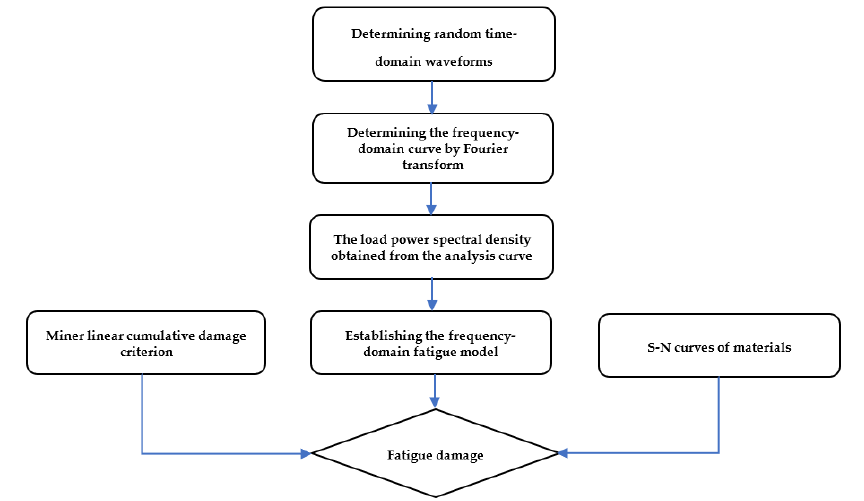
Figure 1. Frequency-domain analysis.